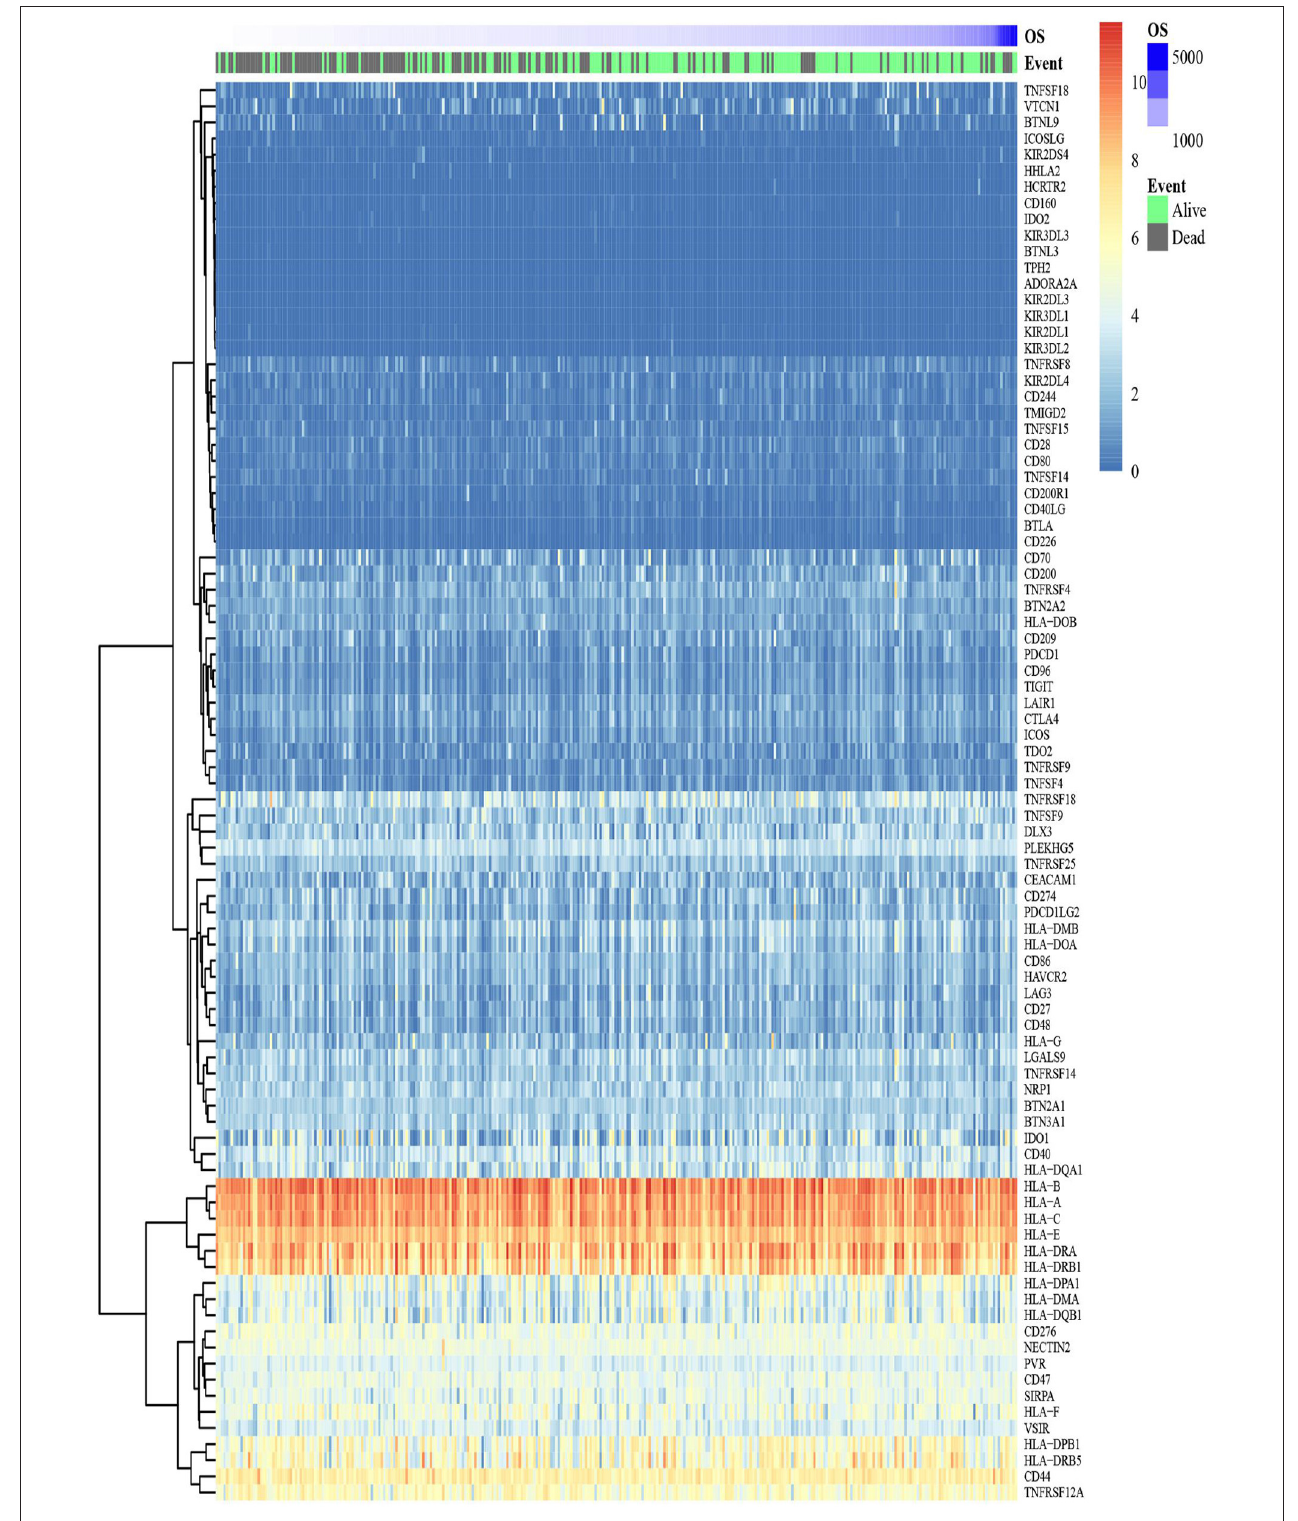
FIGURE 3 | A heat map shows the expression pattern of ICGs in the TCGA-OSCC data set. The color bar refers to the gene expression levels. Red indicates relatively higher gene expression levels, and blue indicates relatively low gene expression levels.